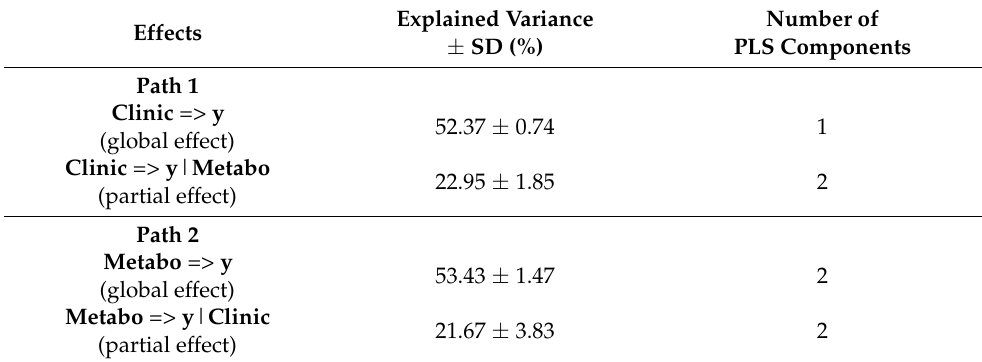
Table 1. Global and partial effects estimated for both paths described in Figure 1.